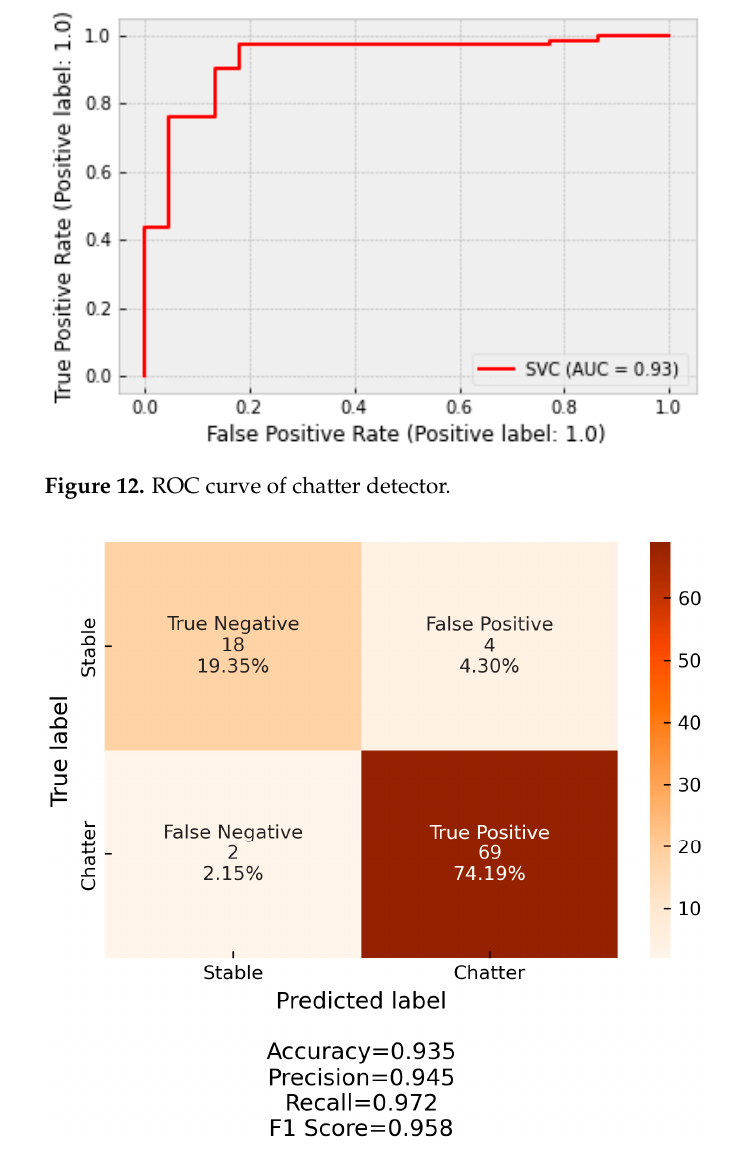
Figure 13. Confusion matrix of chatter detector.